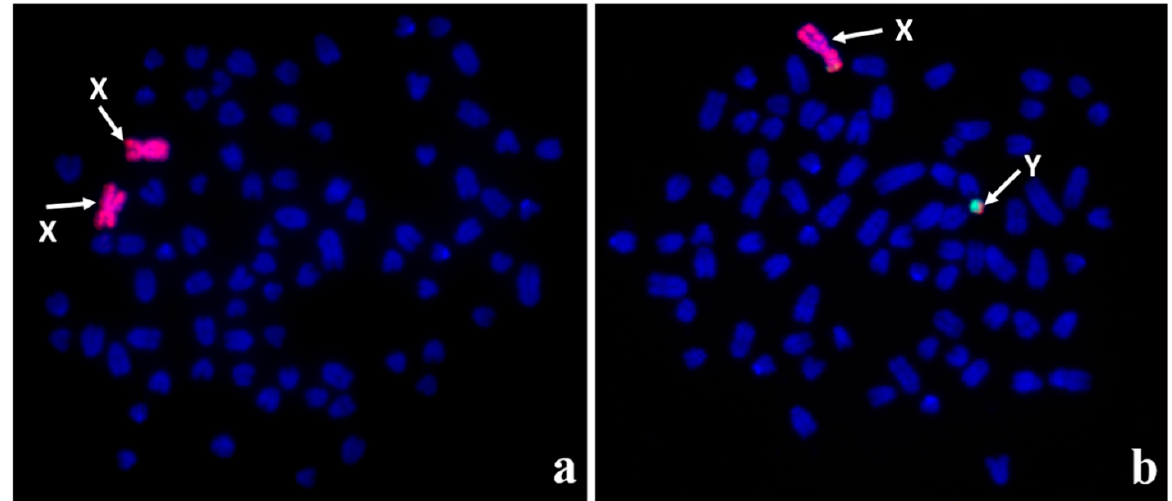
Figure 3. Identification of sex chromosomes by FISH with the use of painting probes (X: red) and (Y: green): ( a ) 78,XX, ( b ) 78,XY, with visible signals in pseudoautosomal region (PAR).